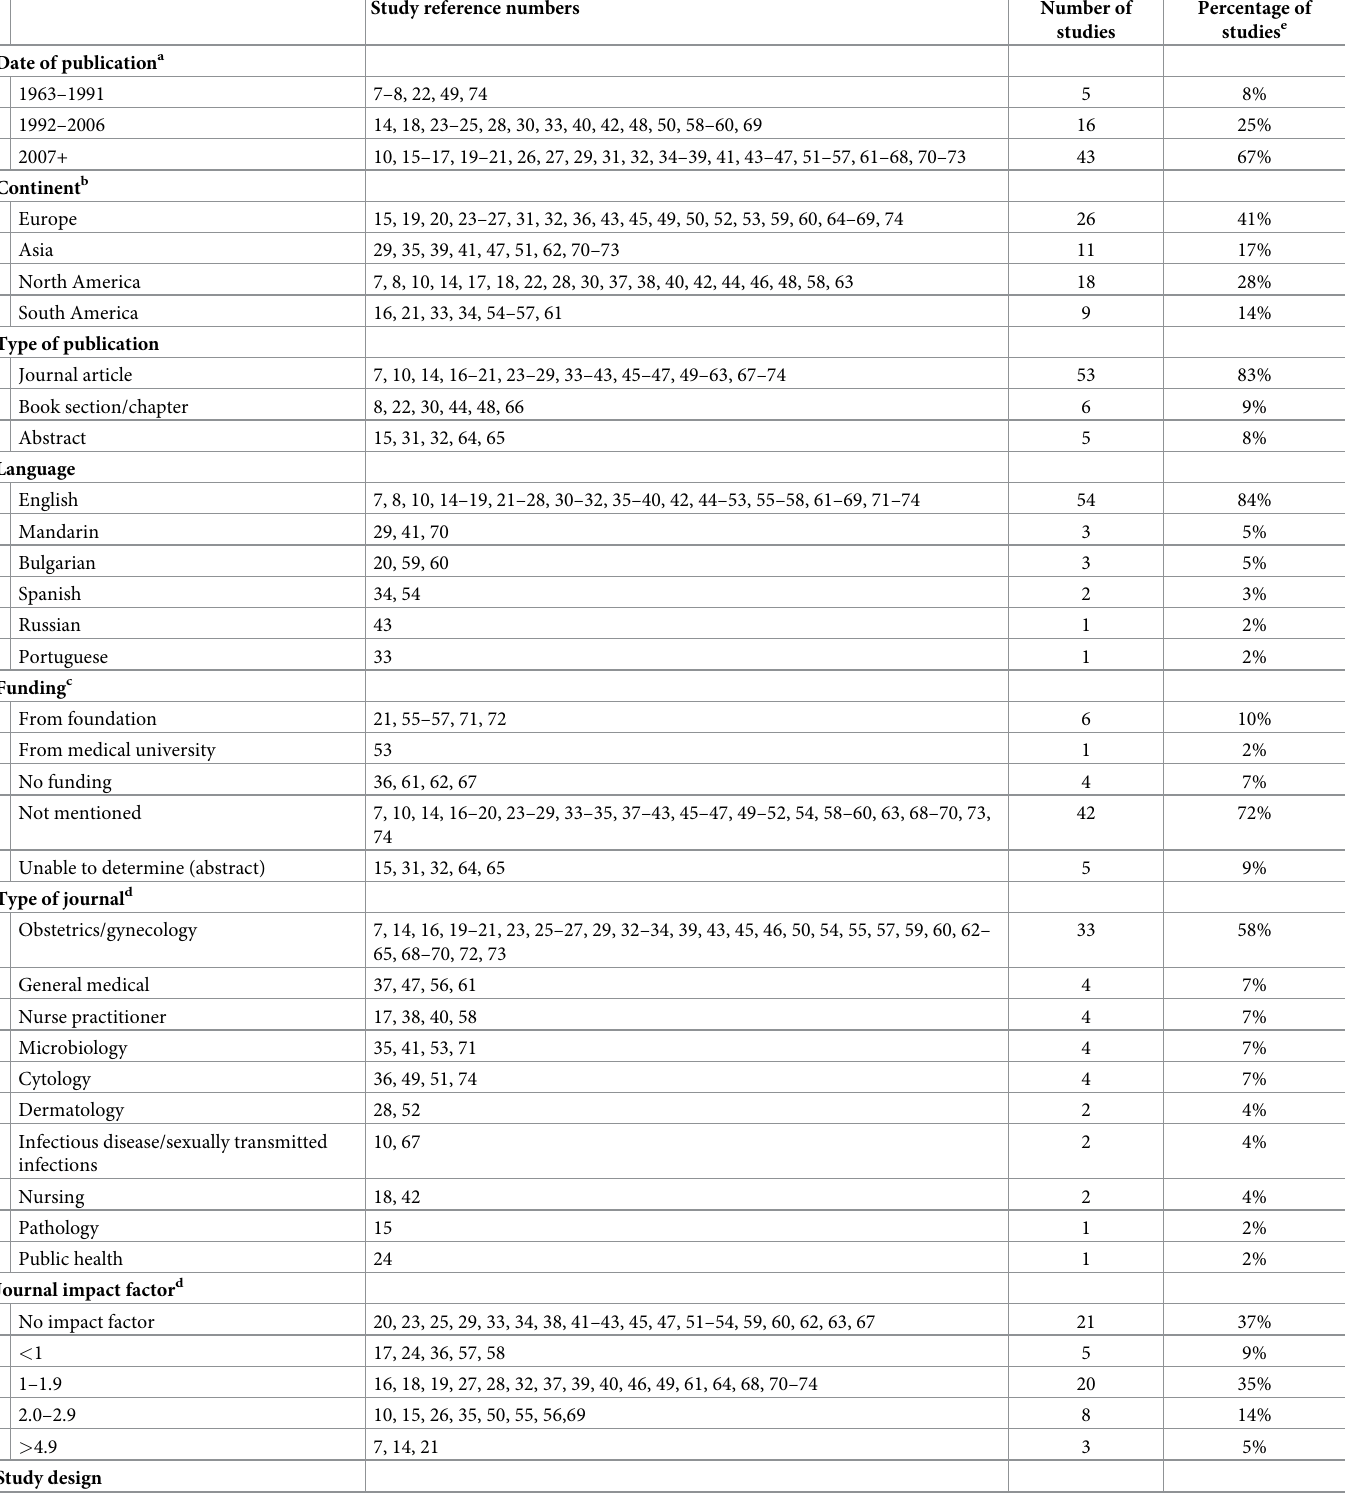
Table 2. Summary of descriptive statistics (n = 64